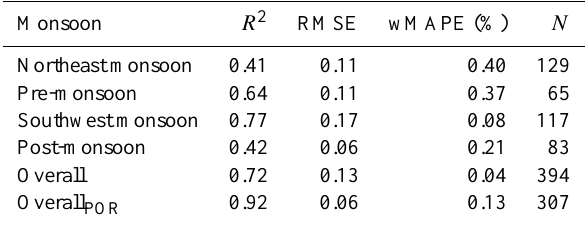
Table 3. Calibration results (data for subset 1) for the AOD predic- tion model (Eq. 2) from 2012 and 2013